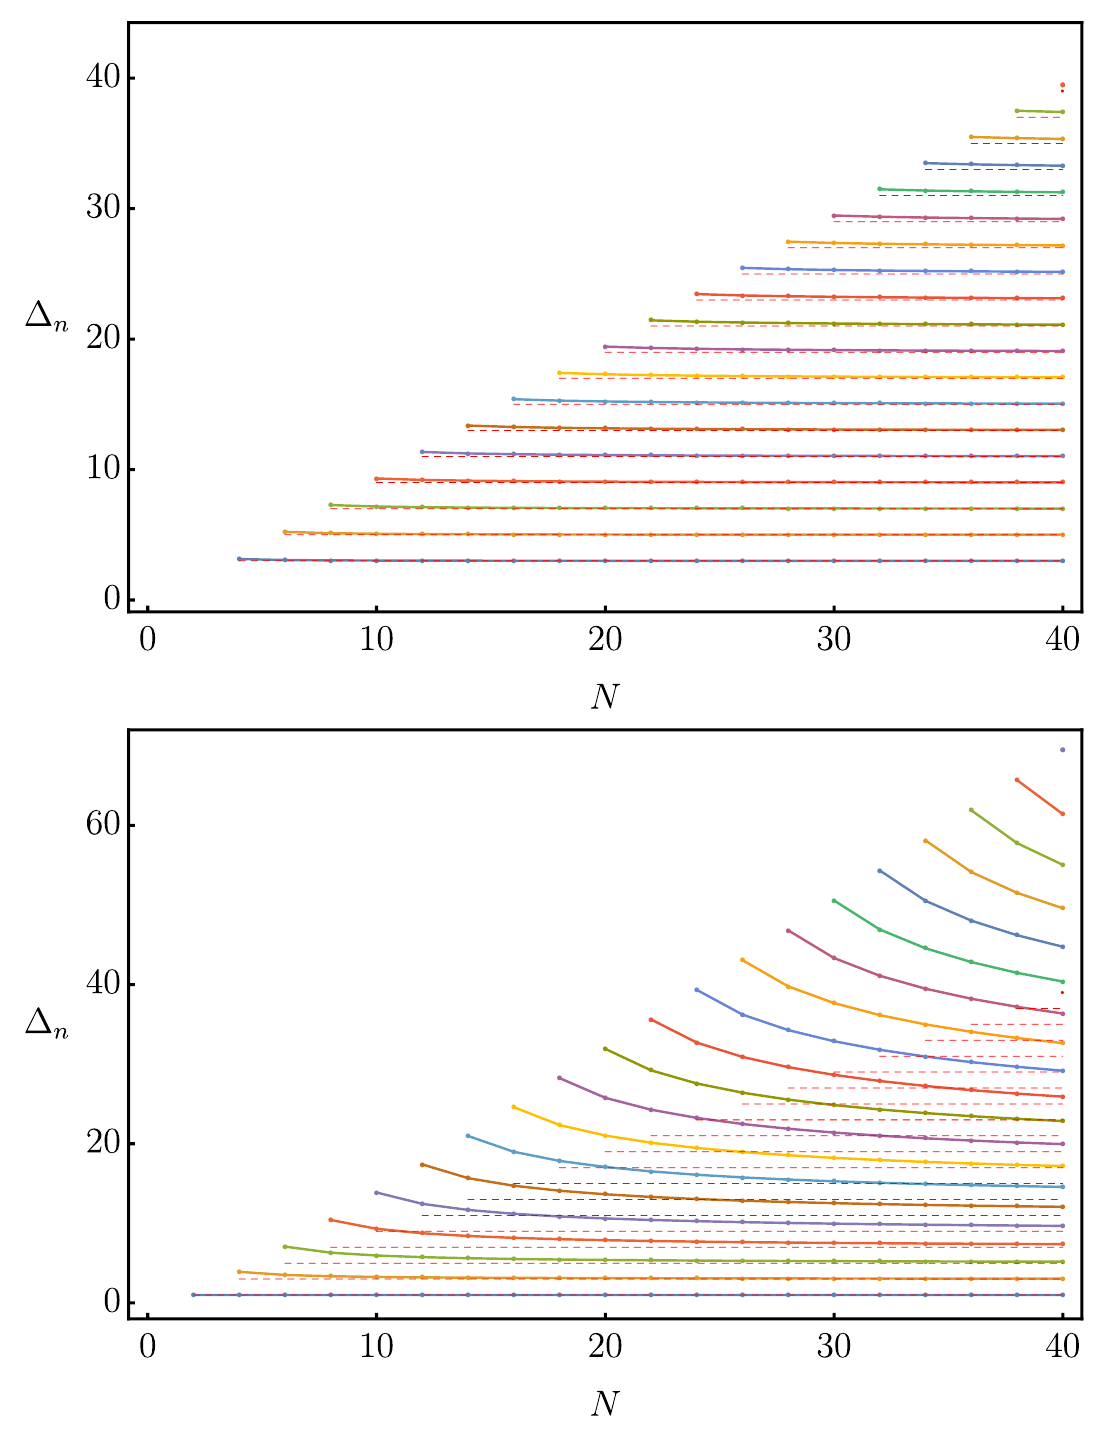
Figure 2 . Spectrum of the solution saturating an OPE maximization bound for (cid:1) (cid:1) (cid:30) = 1 = 2, using the fermionic functional basis (top) and derivatives (bottom). As N is increased by two units a new operator appears, while previous operators approach their correct values shown as dashed lines. With functionals the initial error is smaller and convergence is